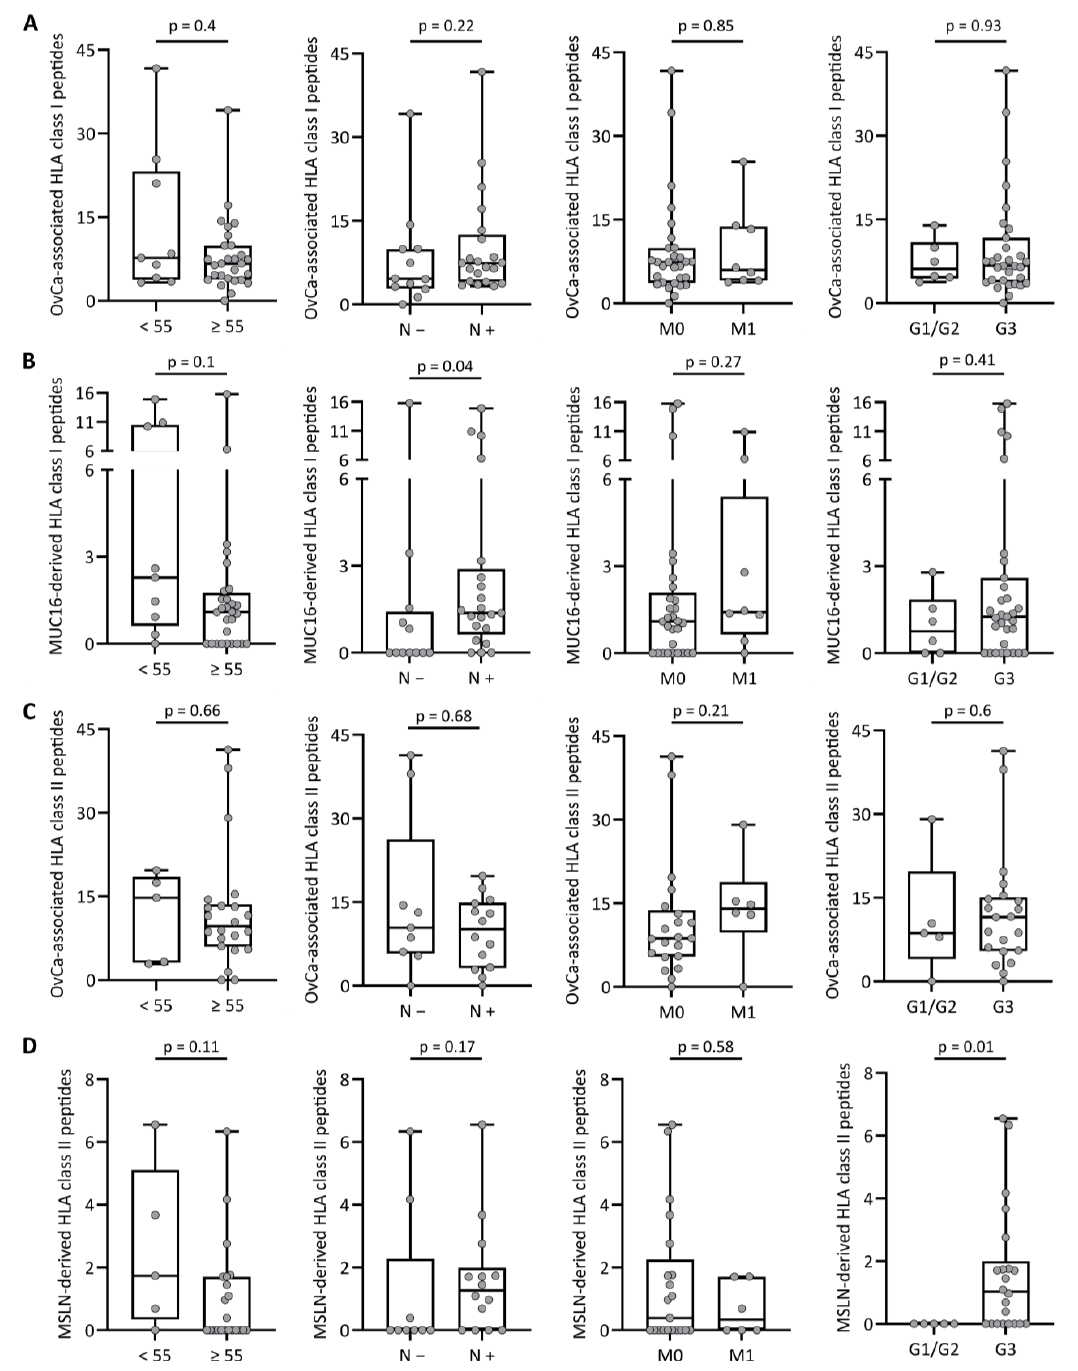
Figure 1. HLA presentation of tumor-associated antigenic peptides according to demographics and tumor characteristics. Number of ( A ) OvCa-associated and ( B ) MUC16-derived HLA class I-presented peptides, as well as ( C ) OvCa-associated and ( D ) MSLN-derived HLA class II-presented peptides identified by the immunopeptidome analysis of primary tumor tissue in relation to demographics and tumor characteristics, including age (left panel), nodal metastases (mid-left panel), distant metastases (mid-right panel) and tumor grading (right panel). Dots represent data from individual patients. Boxes represent the median and 25th to 75th percentiles, whiskers are minimum to maximum, Mann– Whitney U-test. Abbreviations: <55, age below 55 years; ≥ 55, age equal to or over 55 years; N − , no lymph node metastases; N +, lymph node metastases; M0, no sign of distant metastases; M1, distant metastases; G1/2, low/intermediate tumor grading; G3, high tumor grading; and p , p